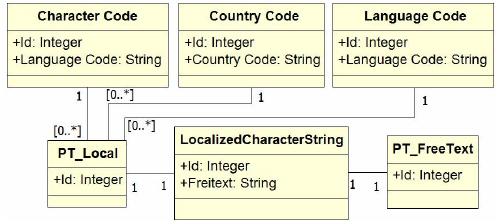
Figure 3: Multilingualism in UML